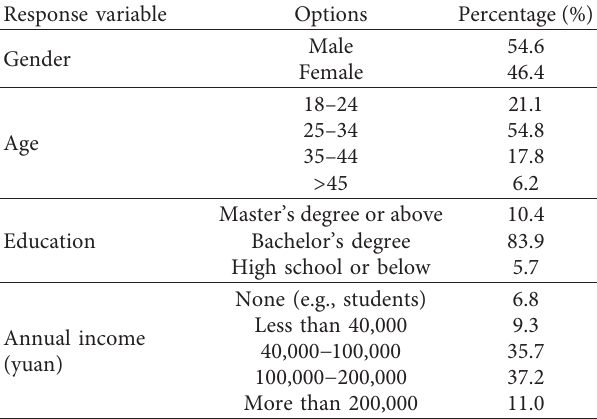
Figure 1: Extended TAM. Table 1: Respondents’ demographic